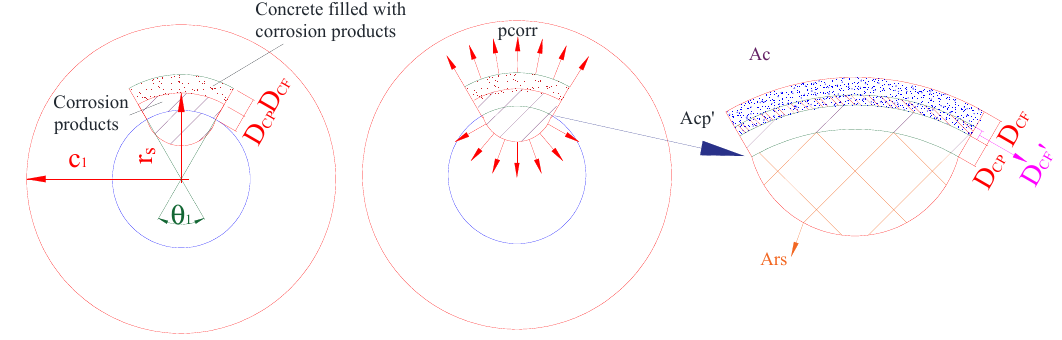
Figure 5. No cracked thick-walled cylinder with expansion stress.